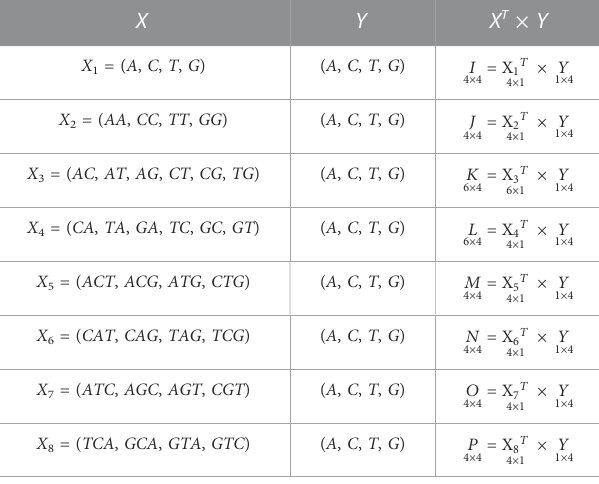
genes. Table 1 lists some of the terminologies employed in the proposed technique for reference.